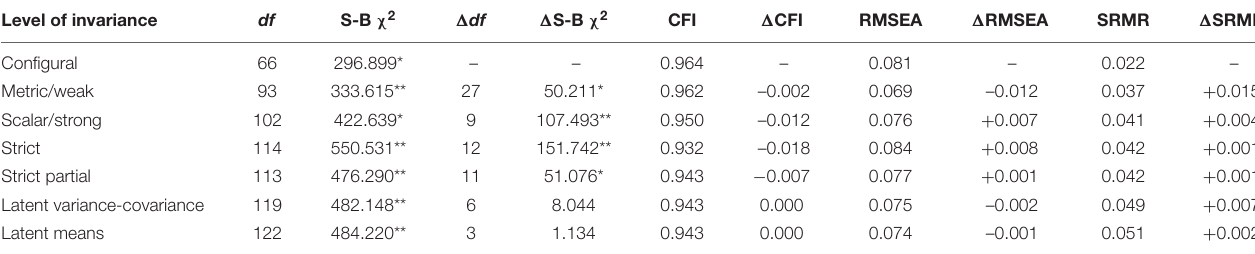
TABLE 3 | Goodness-of-fit indices for tests of measurement invariance ( n = 1,079). Level of